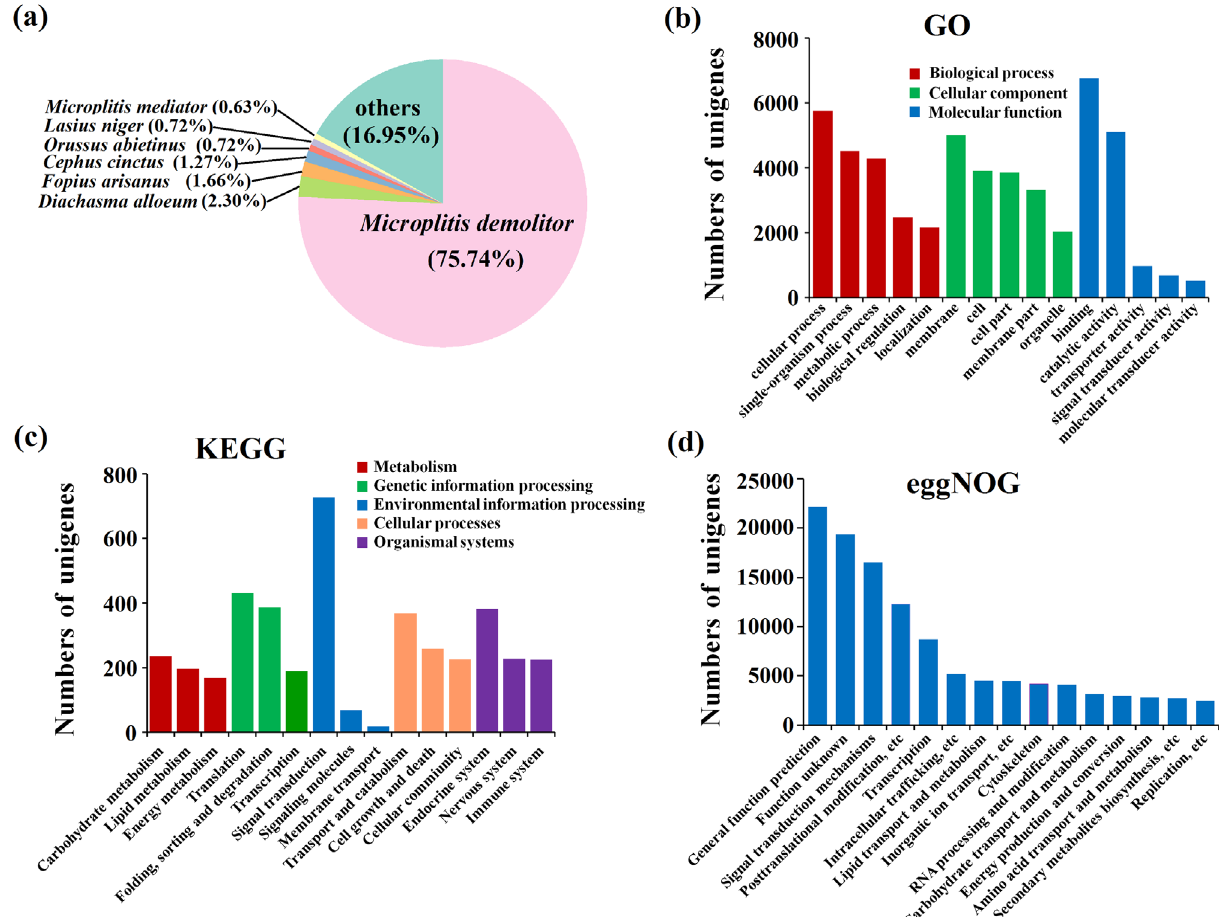
Figure 2. Annotation of transcripts using public databases. (a) Homologous species distribution of M. pallidipes annotated using the NR database. (b) GO enrichment analysis: red, biological process; green, cellular component; blue, molecular function. (c) KEGG pathway analysis: red, metabolism; green, genetic information processing; blue, environmental information processing; yellow, cellular processes; purple, organismal systems. (d) eggNOG annotations: eggNOG categories are on the x -axis and number of transcripts is on the y